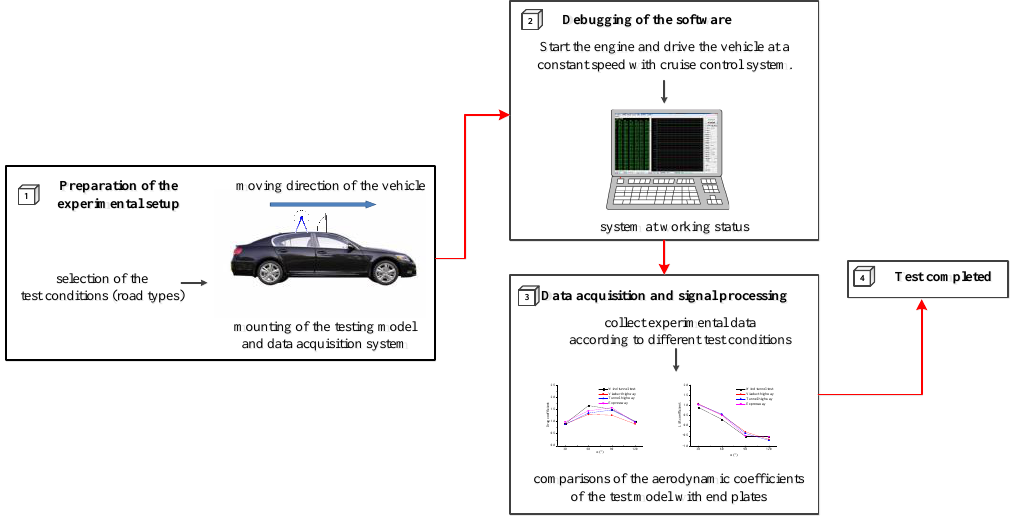
Figure 1. Schematic of the testing